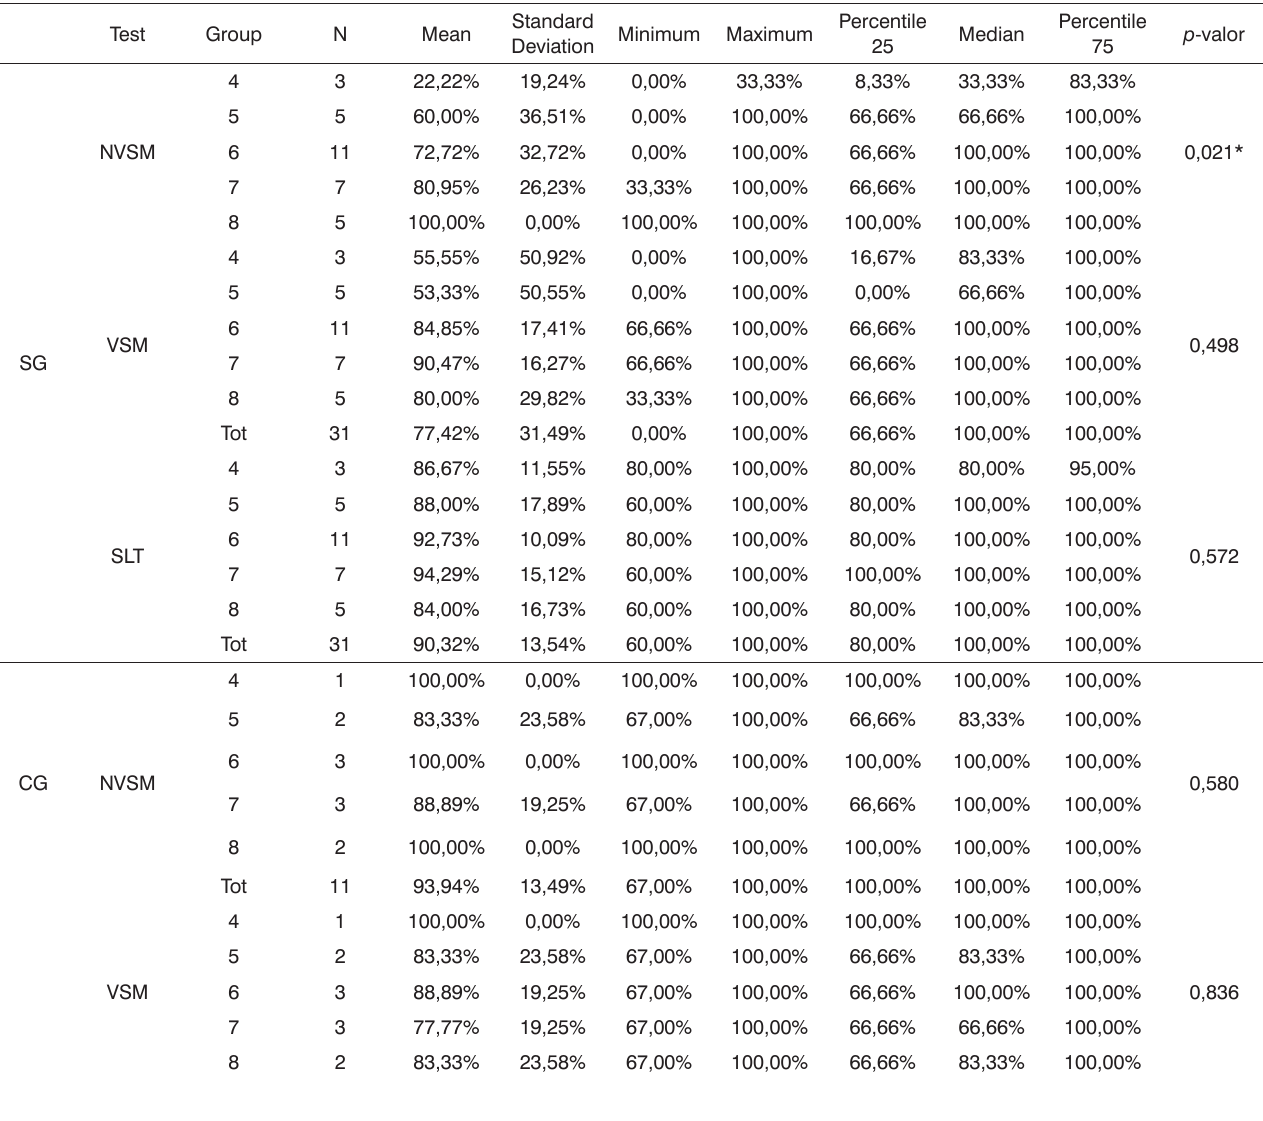
Table 3. Descriptive values of the correct answers from the Simplified Auditory Processing Assessment in the children from the SG and CG and p -value calculated for comparison according to the participants’ ages (in